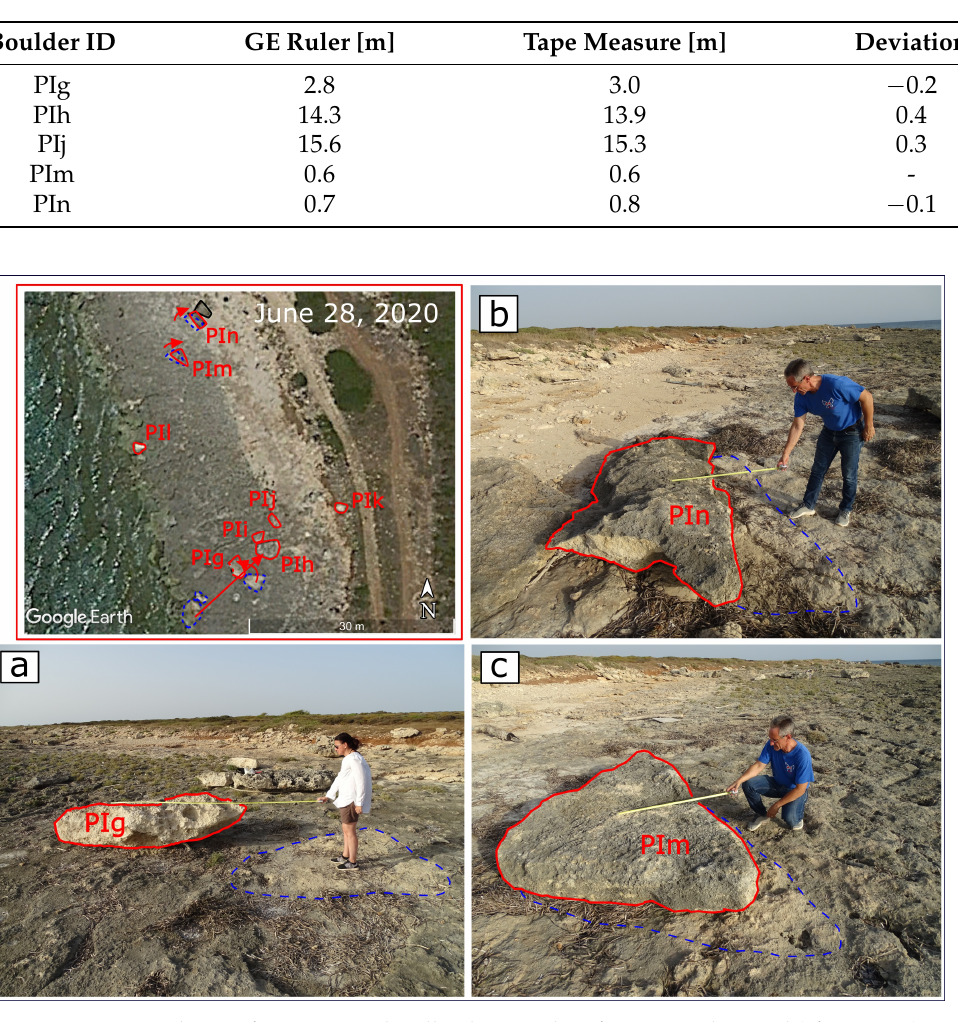
Figure A10. Central area of Punta Pizzo headland, examples of TD ground control (cf. Figure 5). Top left the 28 June 2020 GE image; ( a ) The tape is 3 m long. ( b , c ) The tape is 1 m